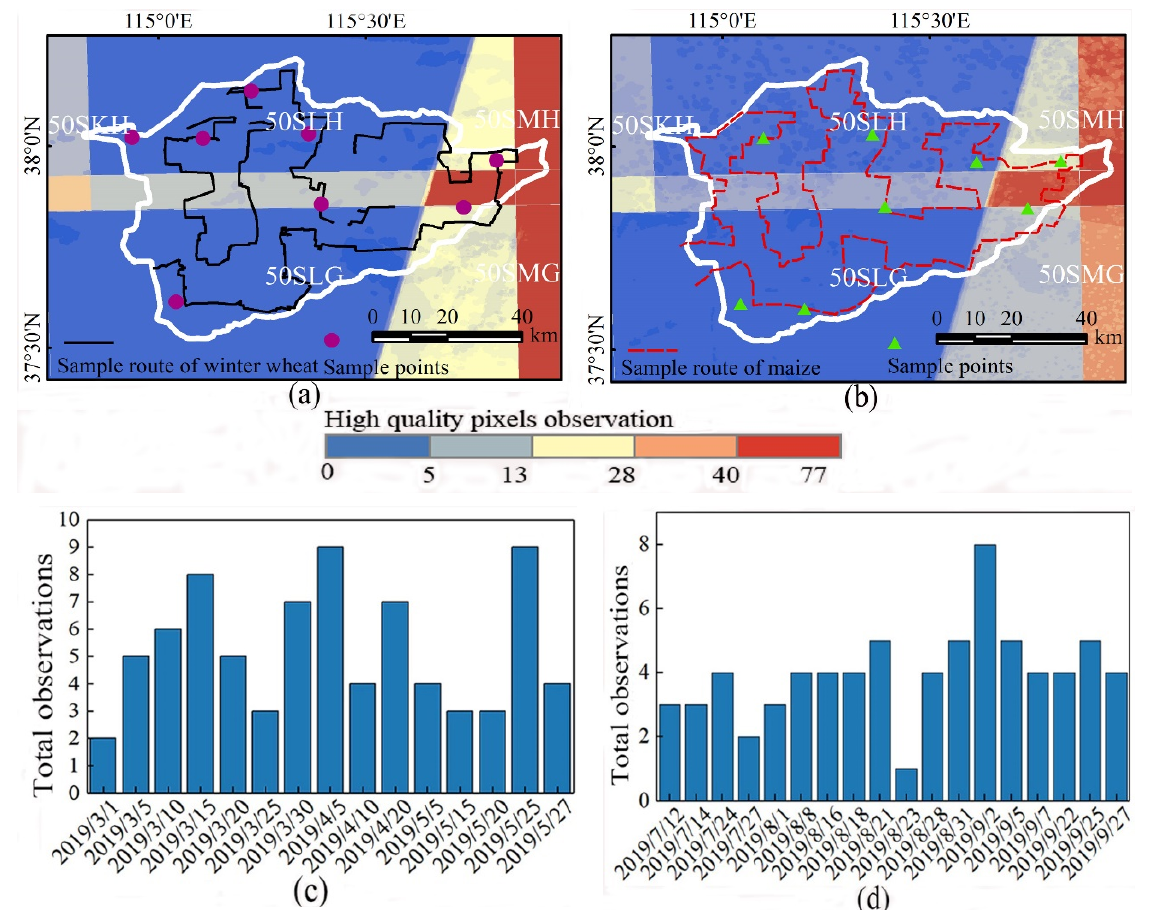
Figure 2. Sentinel-2 product tiles and the number of images at key growth stages. ( a , b ) High-quality pixel observations at the key winter wheat and maize growth stages. ( c , d ) The numbers of images at the key winter wheat and maize growth stages.